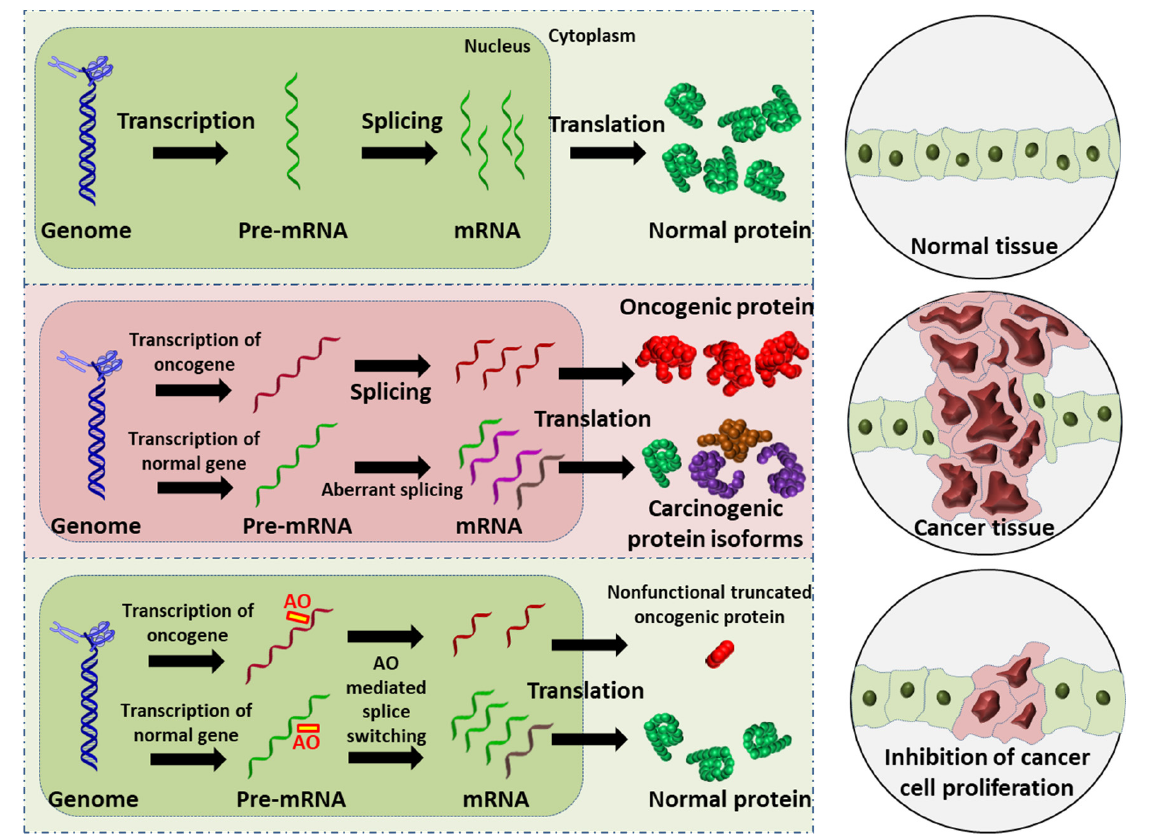
Figure 1. Schematic illustration of the AO-induced anticancer effect. ( Upper ): normal cell and tissue. ( Middle ): activation of oncogene leads to production of oncogenic proteins, and the aberrant splicing of normal gene results in splice variants that are translated into carcinogenic protein isoforms; these carcinogenic proteins collectively promote cancer cell proliferation. ( Lower ): AO-mediated splice switching can not only correct the aberrant splicing, thus reducing the production of carcinogenic protein isoforms (this is the focus of the present review), but can also induce premature stop codons in oncogenic mRNA that results in the synthesis of largely truncated, nonfunctional oncogenic proteins (this is a potential anticancer strategy). Collectively, AO intervention can inhibit cancer cell proliferation.